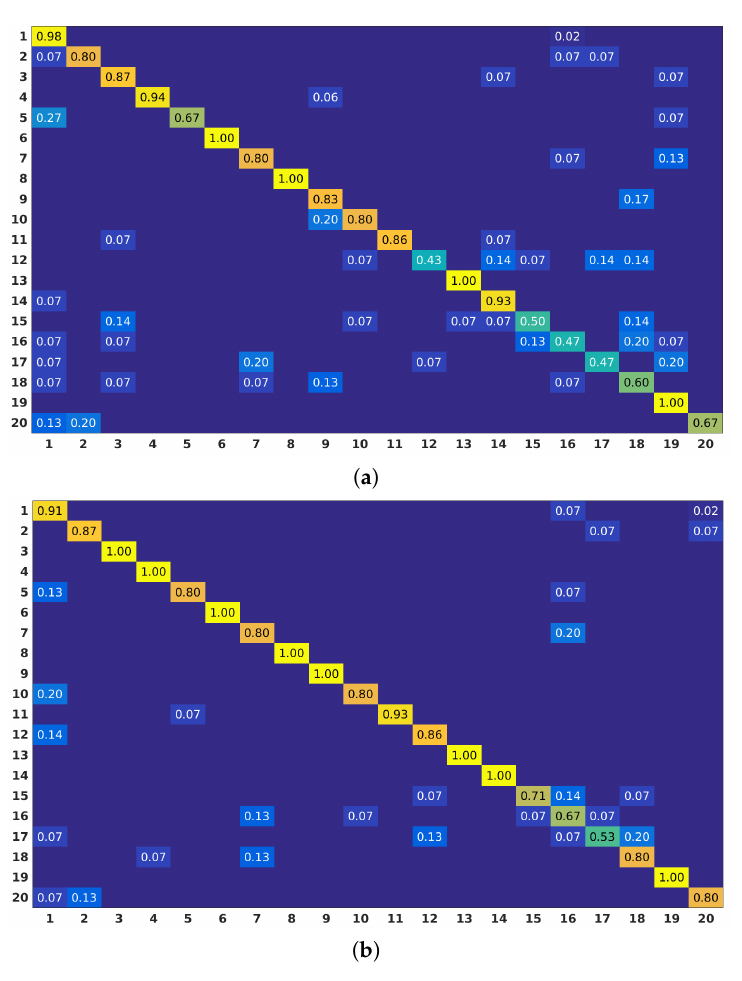
Figure 5. Confusion matrices obtained for Dense Trajectories ( a ) and 2D Localized Trajectories ( b ) approaches on G3D dataset. Actions list: (1) Aim and Fire Gun; (2) Clap; (3) Climb; (4) Crouch; (5) Defend; (6) Flap; (7) Golf Swing; (8) Jump; (9) Kick Left; (10) Kick Right; (11) Punch Left; (12) Punch Right; (13) Run; (14) Steer; (15) Tennis Serve; (16) Tennis Swing Backhand; (17) Tennis Swing Forehand; (18) Throw Bowling Ball; (19) Walk; and (20)